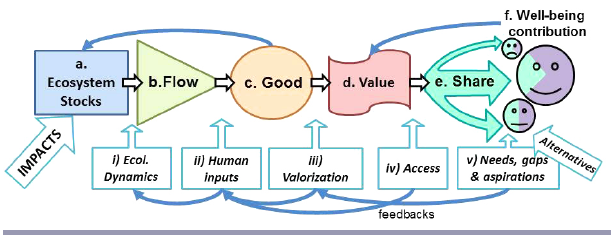
Fig. 2 . A framework to interrogate ecosystem-well-being relationships and shed light on factors affecting ecosystem service elasticity. Ecosystem services are represented as a chain of elements (a-f) that link ecosystem stocks to well-being (See Table 1 for definitions, Table 2 for examples, and text for further elaboration).